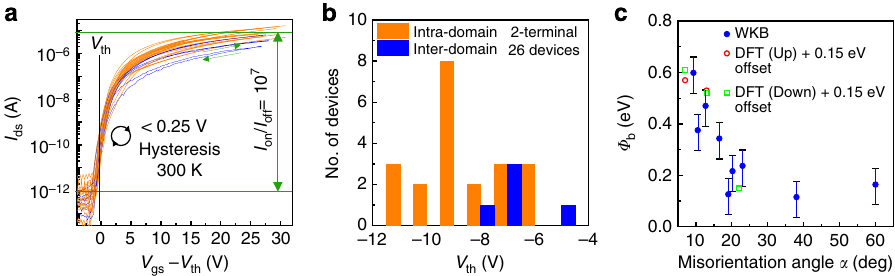
Figure 3 | Extraction of Schottky barrier height from the threshold voltage. ( a ) Dual sweep I ds - V gs data for 26 different intra-/inter-domain two-terminal FETs at 300K. Consistent and trivial 0.25-Vclockwise hysteresis was observed for all 26 devices, regardless of the inter-/intra-domain status. Intra-domain devices have an average I on / I off ¼ 10 7 at 300K, while the inter-domain I on / I off was reduced and misorientation angle-dependent. ( b ) Distribution of V th from panel ( a ) with a bin size of 0.25V. The median of the inter-domain V th was shifted by þ 1.6V from that of the intra-domain. ( c ) Inter-domain tunneling barrier height F b calculated via JWKB approximation when assuming a parabolic barrier shape and a transmission probability T gb ¼ m FE(inter) / m FE(intra) . The error bars are based on one standard deviation of the intra-domain m